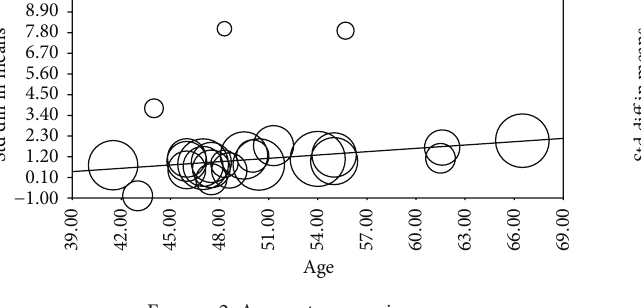
Figure 4: BMI metaregression.